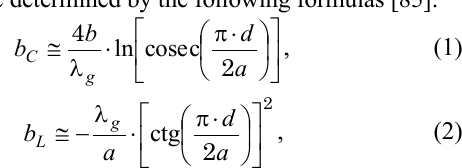
(b) FIGURE 2. Equivalent networks of a polarizer with a diaphragm of capacitive type (a) and inductive type (b) . The equivalent conductivities of diaphragm in a